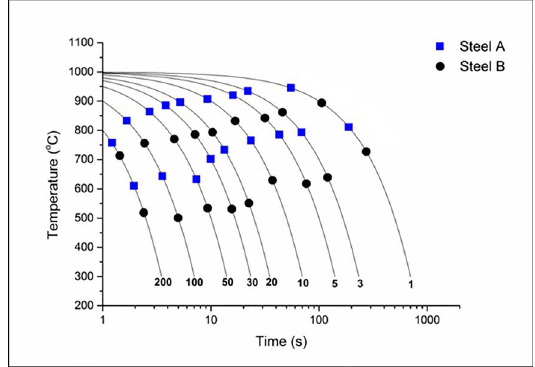
Figure 2. Comparison between the experimental CCT diagrams for steels A and